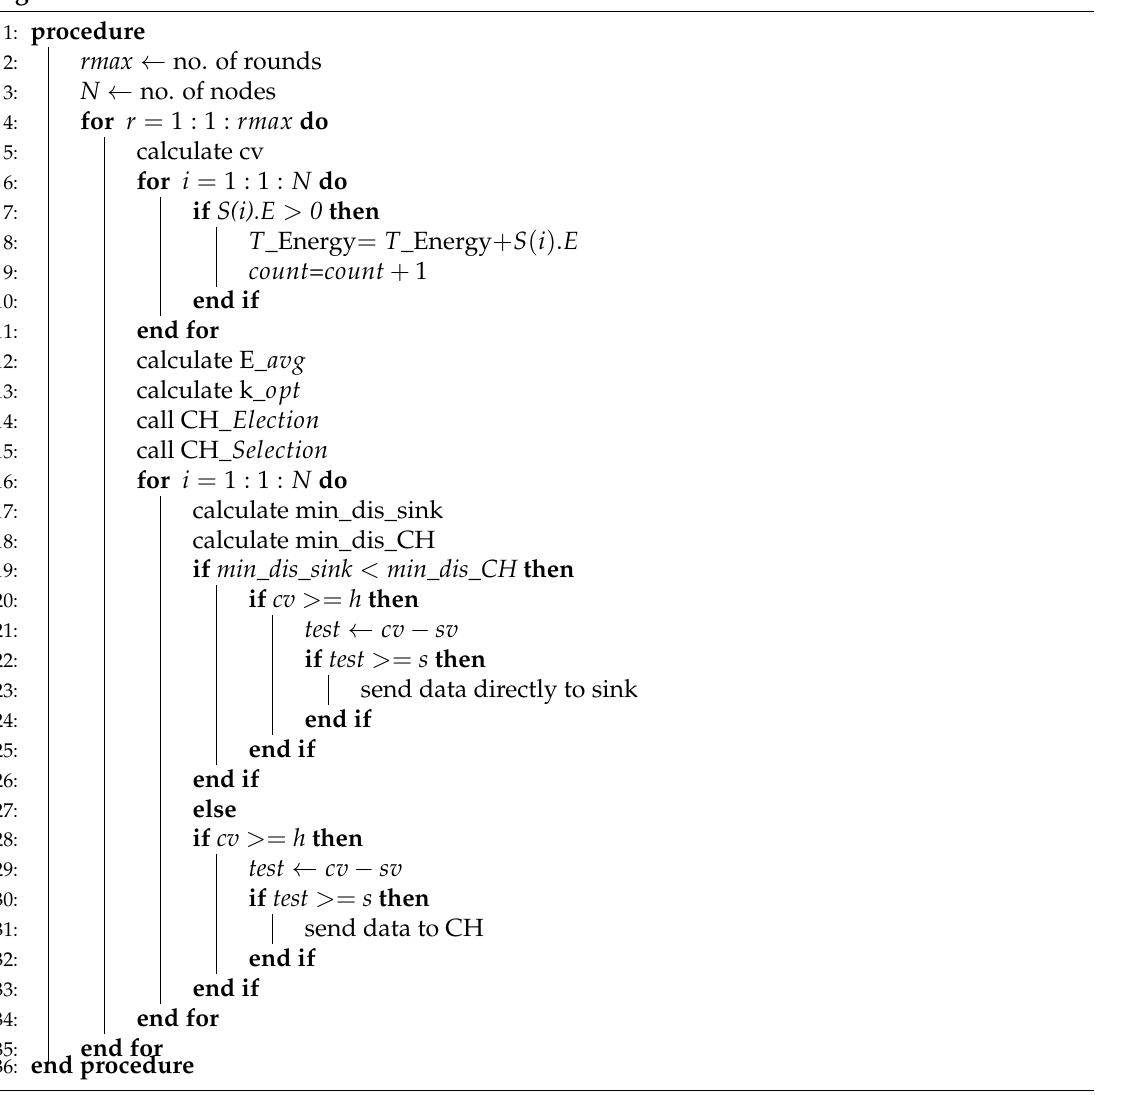
Algorithm 2 TEEN-ACH 2